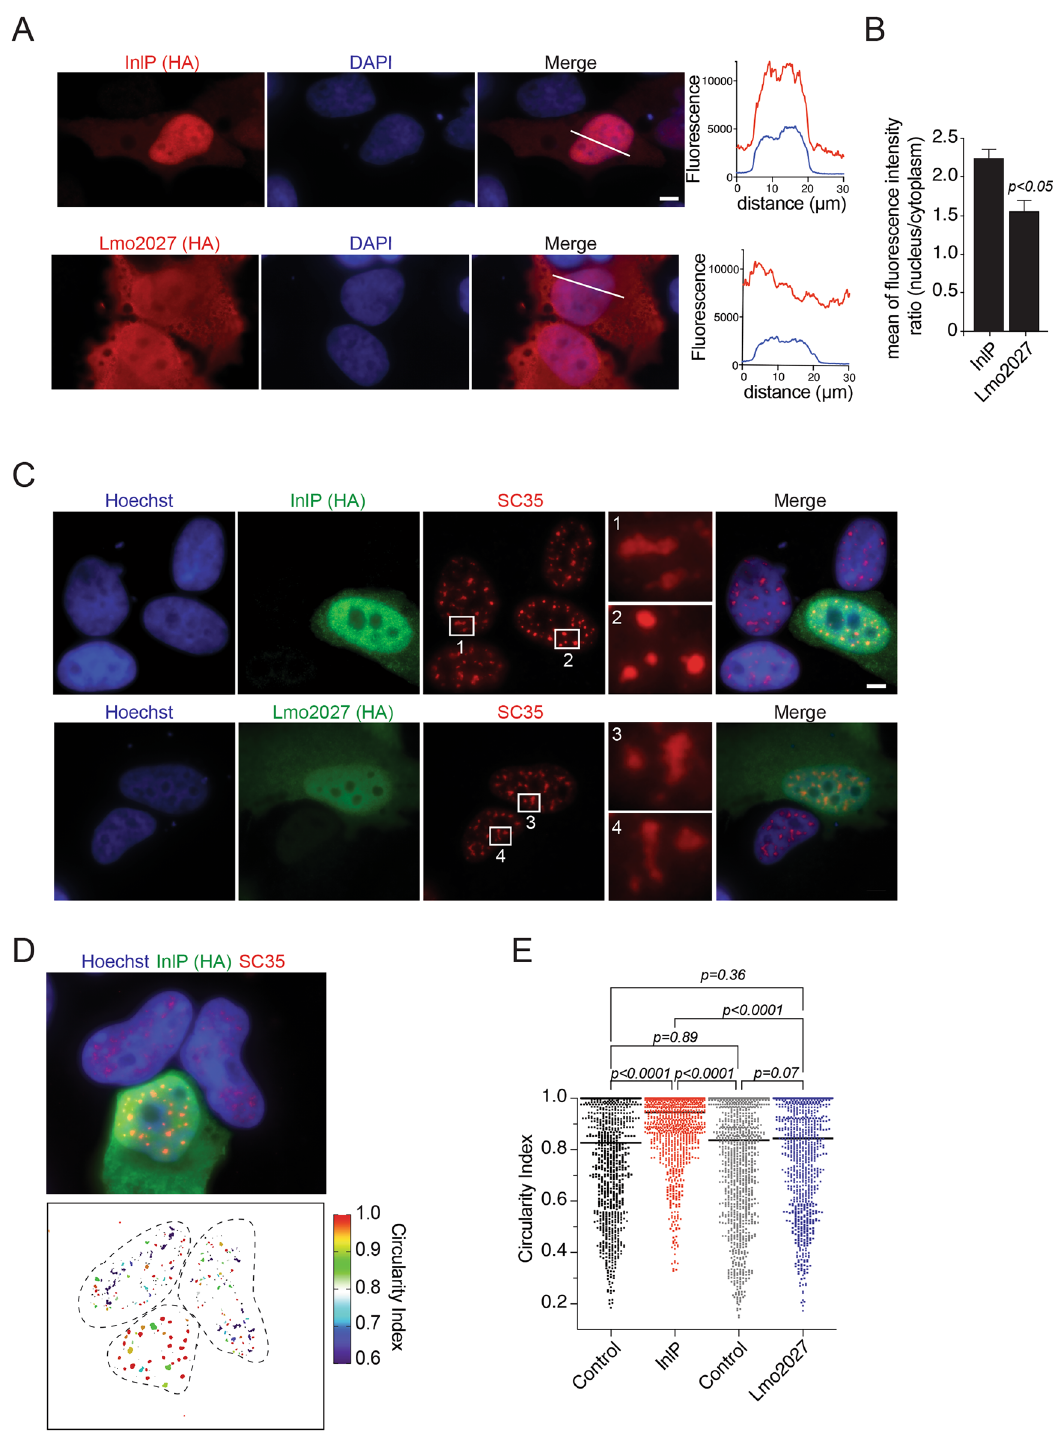
Figure 2. InlP translocates to the nucleus and changes the shape of splicing speckles. ( A ) Left, representative immunofluorescence images of HeLa cells transfected with InlP- HA or Lmo2027- HA and stained with an HA antibody and DAPI. Right, corresponding pixel intensity plot for white lines drawn on the left. Scale bar 10 µm. ( B ) Nucleus to cytoplasm fluorescence intensity ratios of InlP- HA or Lmo2027- HA , as determined with ICY software. Data are mean ± SD of triplicate experiments (n = 22 cells per replicate). ( C ) Immunofluorescence of InlP- HA or Lmo2027- HA and endogenous SC35 in HeLa cells transfected as in ( A ) and stained with HA and SC35 antibodies and Hoechst. Scale bar 10 µm. Representative SC35-positive speckles are enlarged in squares 1 and 4 for non-transfected cells, in square 2 for InlP-transfected cells, and in square 3 for Lmo2027-transfected cells. ( D ) Nuclear speckle circularity in HeLa cells transfected with InlP- HA . On the top is a representative image stained as in ( C ) with SC35-positive nuclear speckles in red. Below, the color-coded representation of nuclear speckle circularity index. ( E ) Scatter plot of the circularity index of nuclear speckles from at least 20 cells transfected as in ( C,D ) determined by ImageJ software. The bar represents the median. Statistical significance determined by